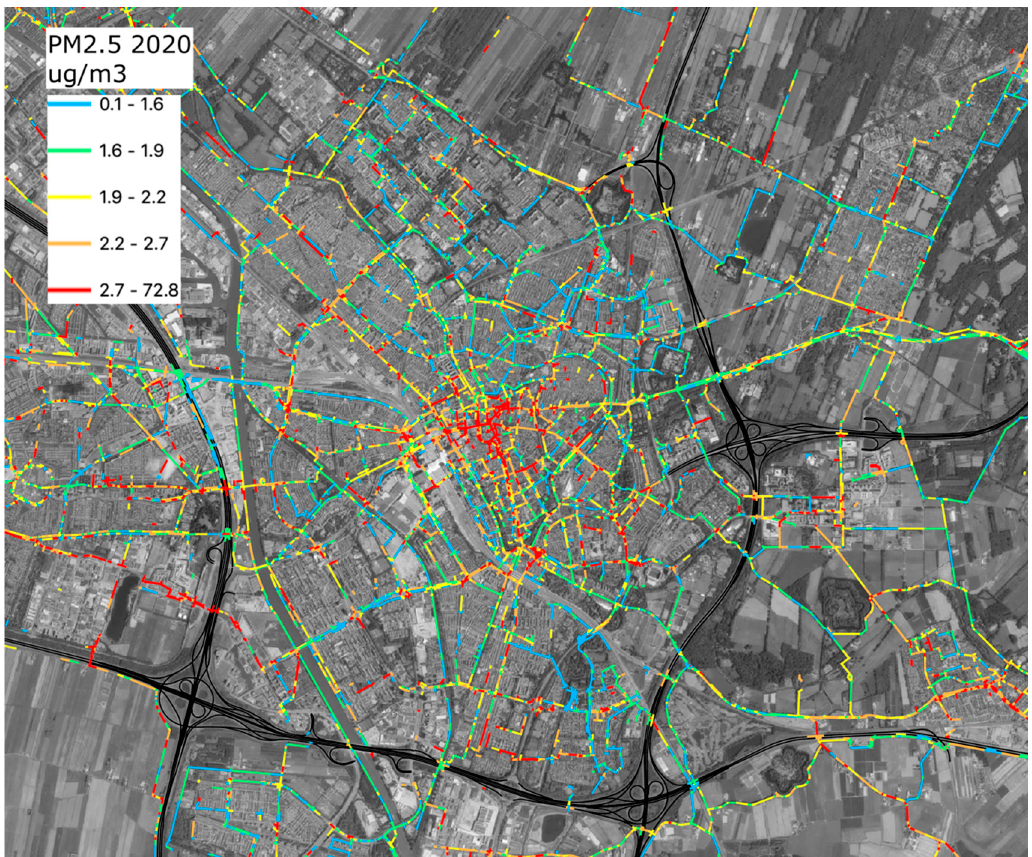
Figure 13. Average PM 2 . 5 concentration contributions due to local traffic in the city of Utrecht. All concentrations in μ g/m 3 .